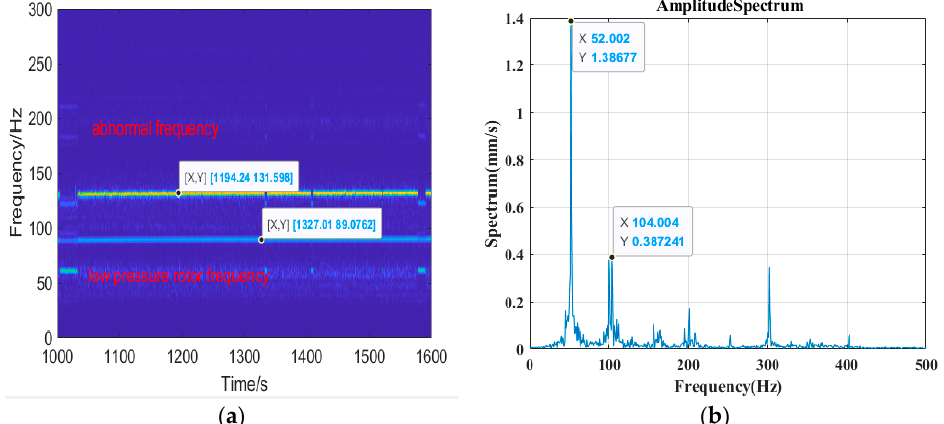
Figure 9. Time–frequency analysis of gas turbine rotor faults. ( a ) Misalignment. ( b ) Unbalanced.